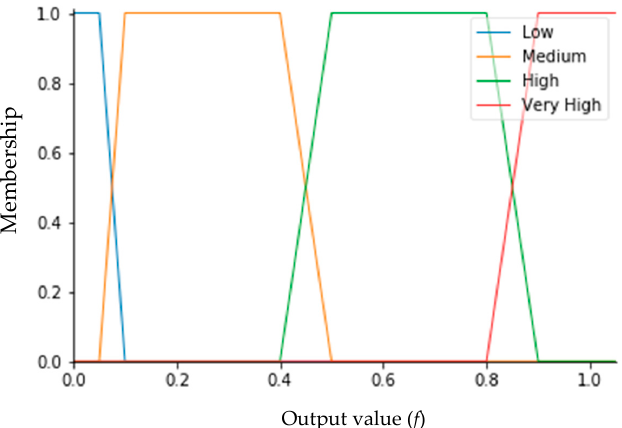
Figure 10. Membership functions for sunshine duration (SD) sensor voltage.